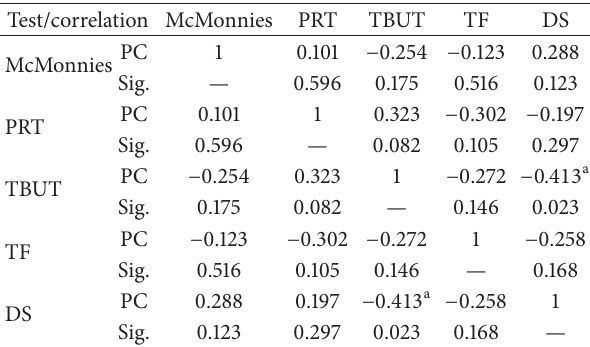
Table 2: Correlation between McMonnies questionnaire scores, PRT, TBUT, TF grades, and duration of smoking within smoker subjects ( 𝑁 = 30 ).